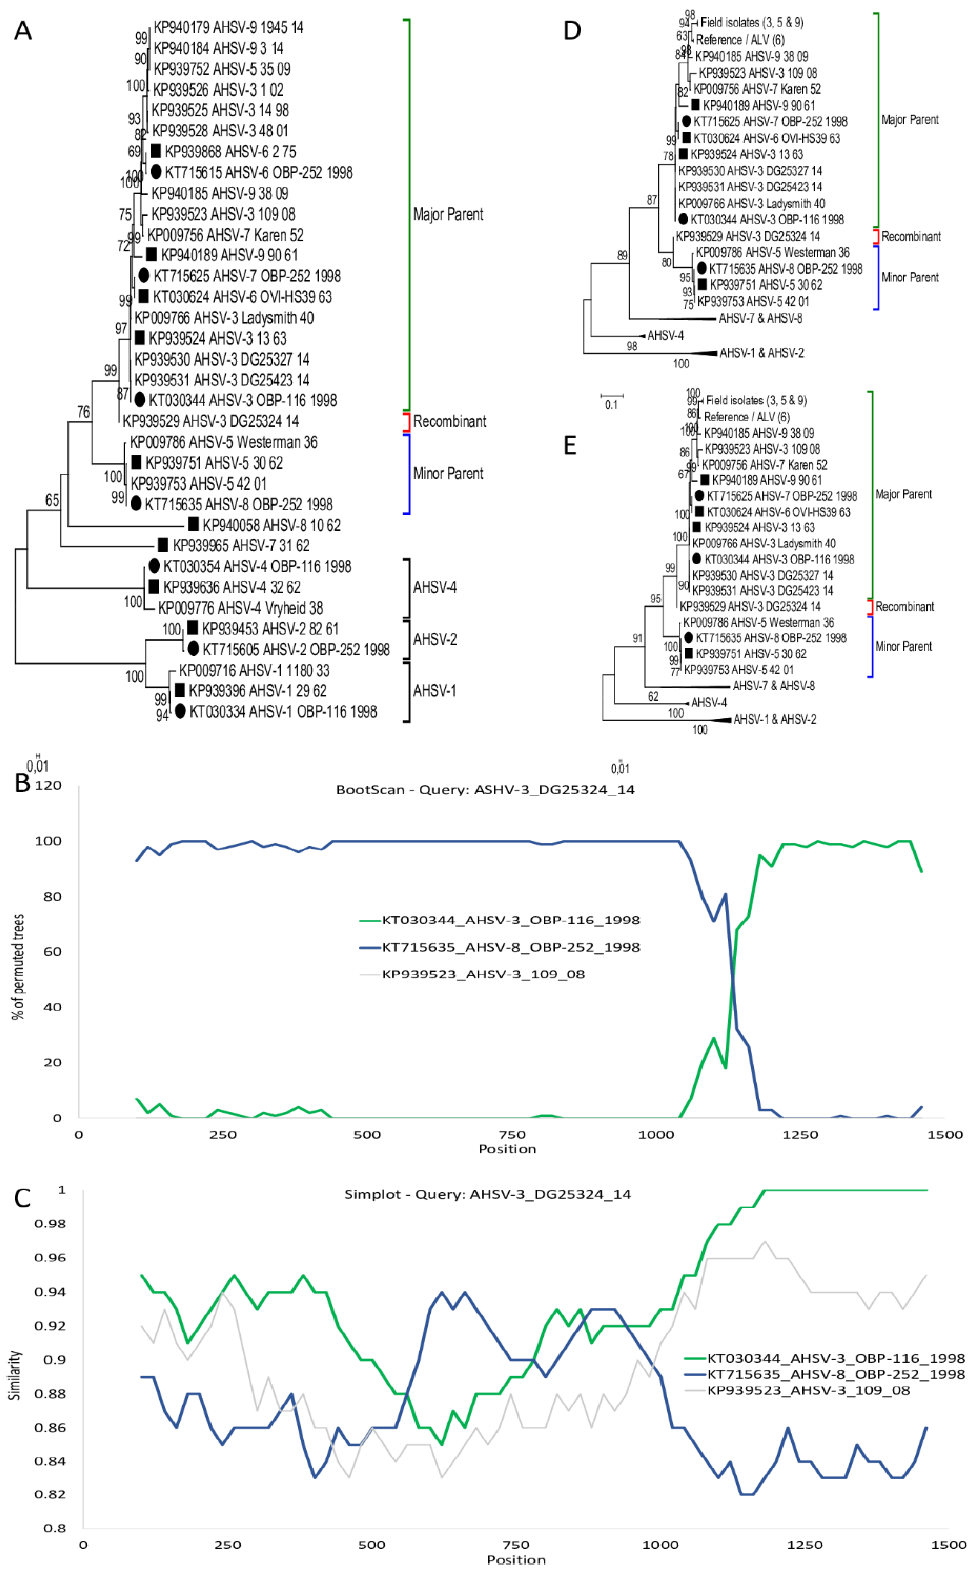
Figure 2. Evidence of intragenic recombination in Segment-6 of KP939529_AHSV-3_DG25321_14. ( A ) ML phylogenetic tree showing the relationship of segment-6 using selected African horse sickness virus (AHSV) isolates. Reference isolates are indicated with a square, while attenuated live virus